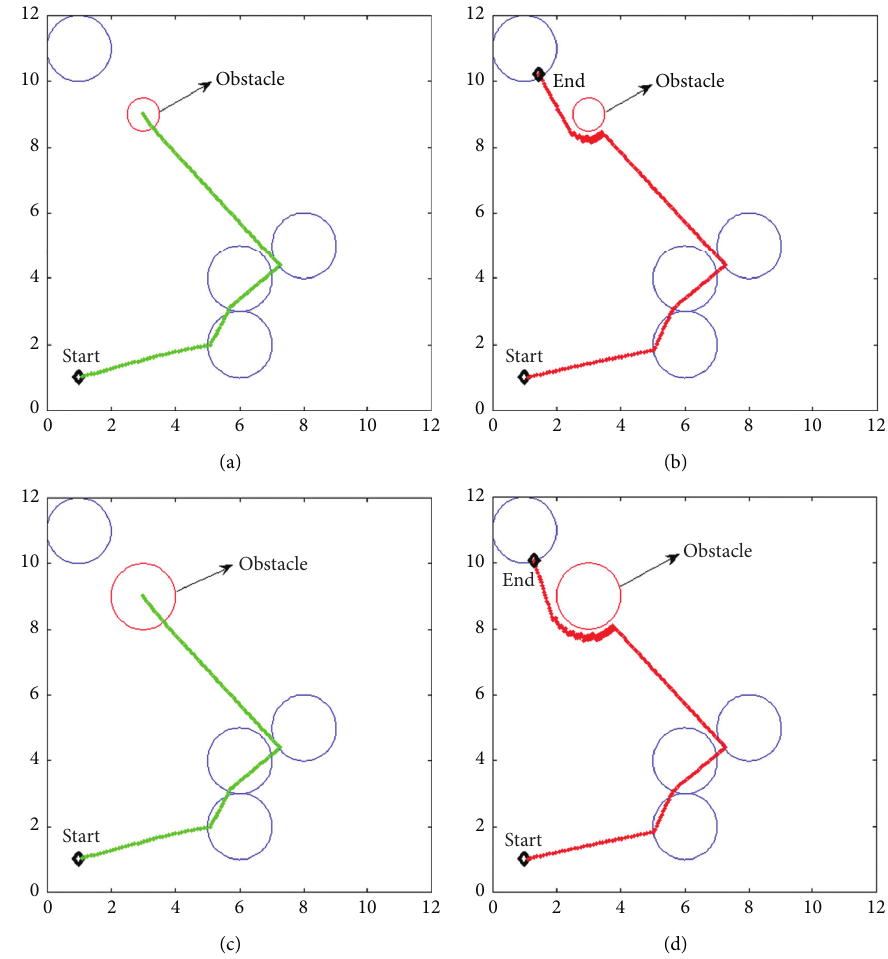
Figure 7: Comparison results for obstacle avoidance performance of robot based on two algorithms. The correspondences are green line-PS and red line-PDS. (a, b) r j � 0.5. (c, d) r j �